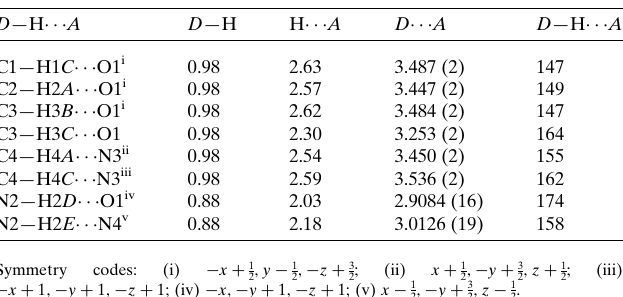
Table 2 Hydrogen-bond geometry (A˚ , (cid:4) ).